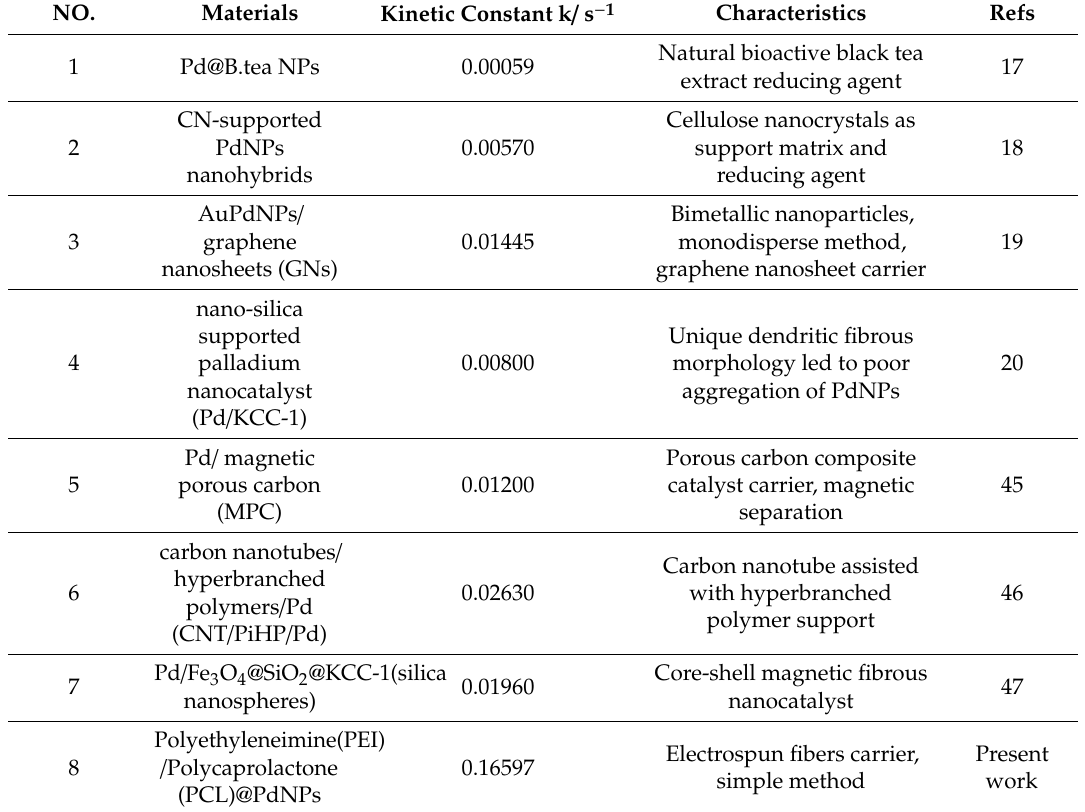
Table 2. Comparative characteristics and catalytic performance of PdNPs-based